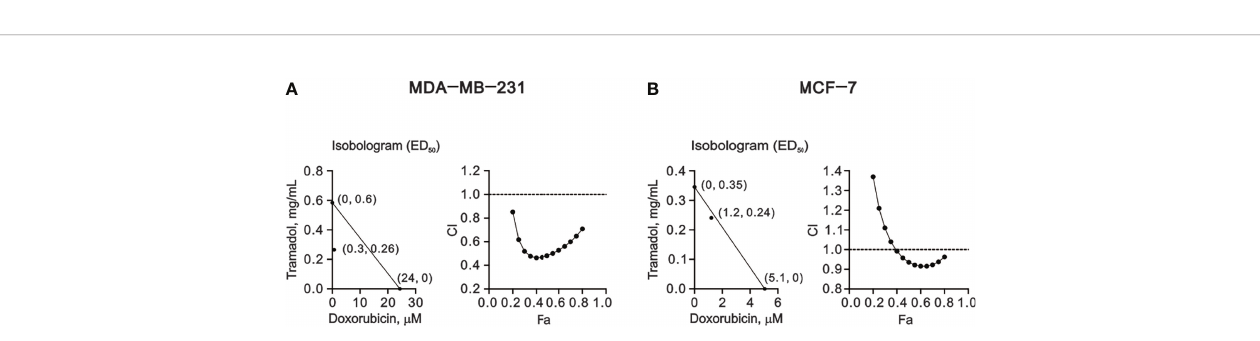
FIGURE 6 | The combination index (CI) of combination treatment of tramadol and doxorubicin in human breast cancer cells. (A, B) MDA-MB-231 and MCF-7 cells were treated with tramadol (0, 0.0625, 0.125, 0.25, 0.5, 1, 2 and 4 mg/mL) and doxorubicin (0, 0.0390625, 0.078125, 0.15625, 0.3125, 0.625, 1.25, 2.5, 5 and 10 mM) for 24 h. The experimental points below the line correspond to CI <1, indicating a synergistic